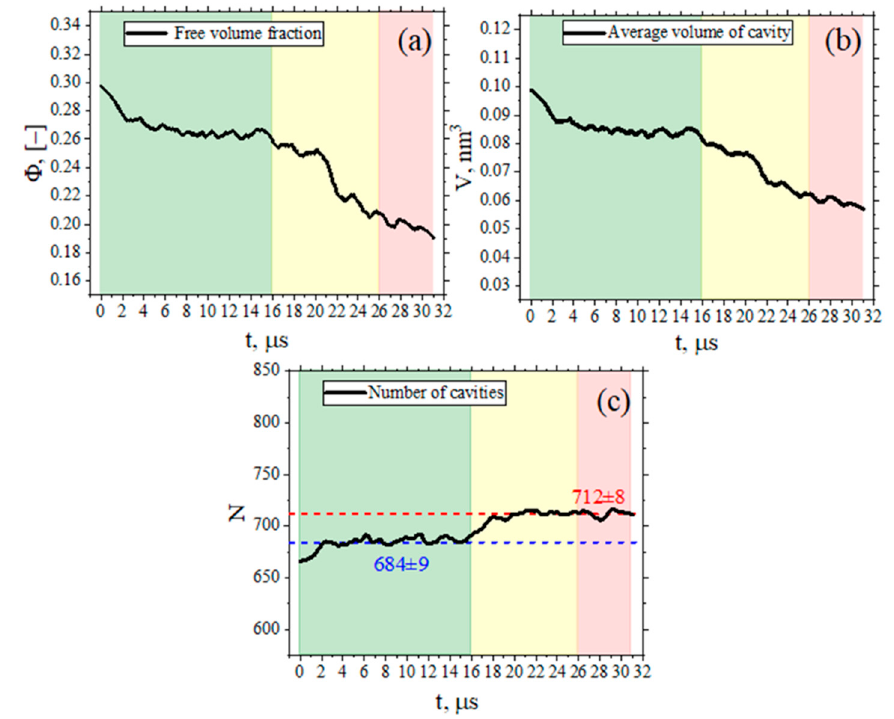
Figure 4. Time dependence of ( a ) the free volume fraction Φ , ( b ) the average volume of cavity V and ( c ) the number of cavities in the simulation box N . Dashed lines denote the average number of cavities in the amorphous (blue) and ordered (red) states with the mean square error.